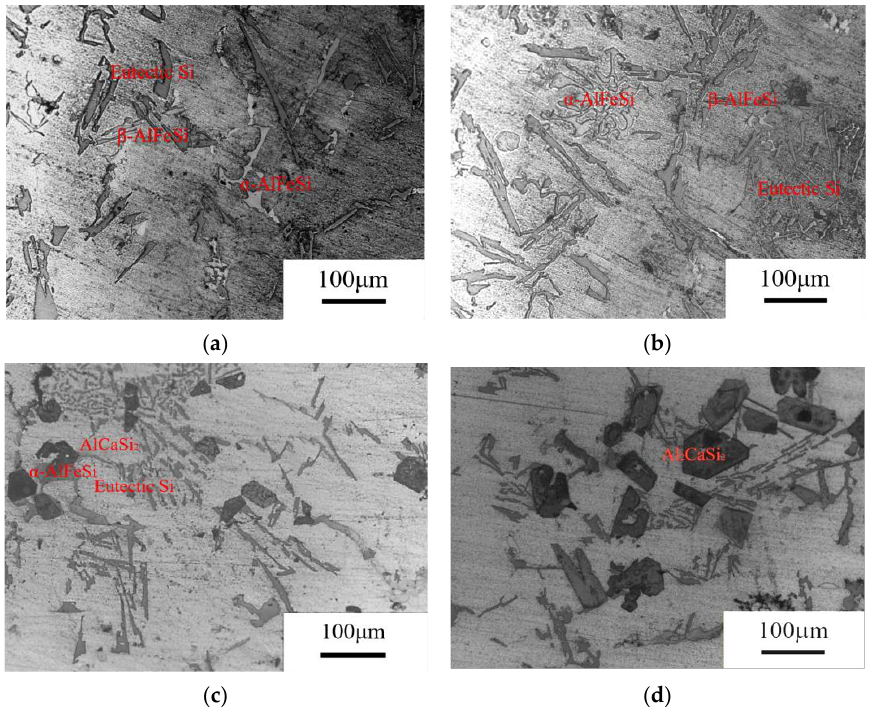
Figure 2. Microstructure of the A380 alloy with different Ca additions at 0.05 °C/s cooling rate: ( a ) 0.01 wt.%; ( b ) 0.05 wt.%; ( c ) 0.1 wt.%; ( d ) 0.3 wt.%.